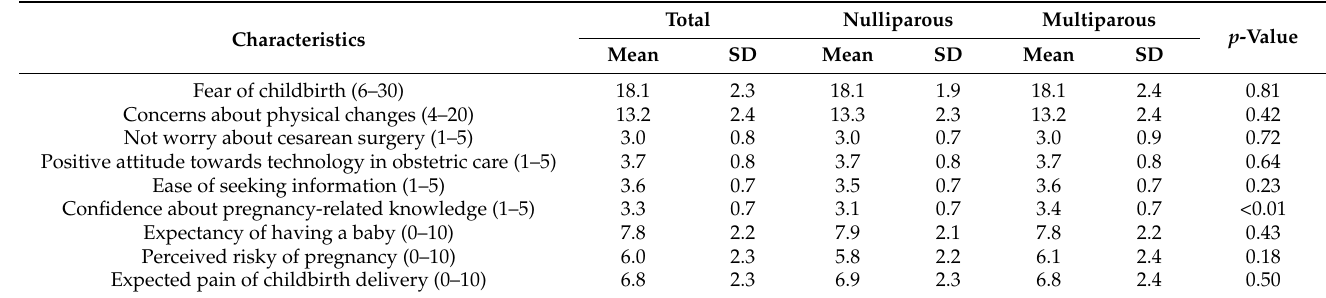
Table 2. Fear of childbirth and attitudes toward different birth aspects.